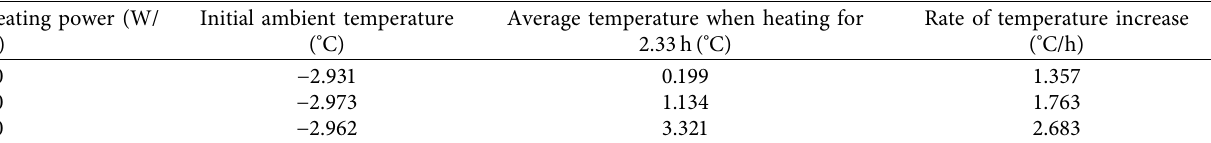
Figure 9: Curve of the surface temperature change of the test specimen at different powers. Table 10: Rate of the surface temperature increase of the test specimen at different powers.